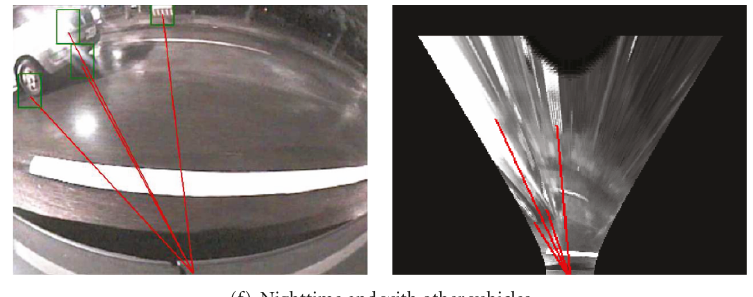
Figure 28: The results in di ff erent environments with heavy noise. (a) In the daytime with many shadow e ff ect. (b) In the nighttime with self shadow projected by several di ff erent direction road lights. (c) In the raining daytime on wet grounds with light reflection. (d) In the raining night time on wet grounds with strong light reflection. (e) Daytime with other vehicles. (f) Nighttime with other vehicles.